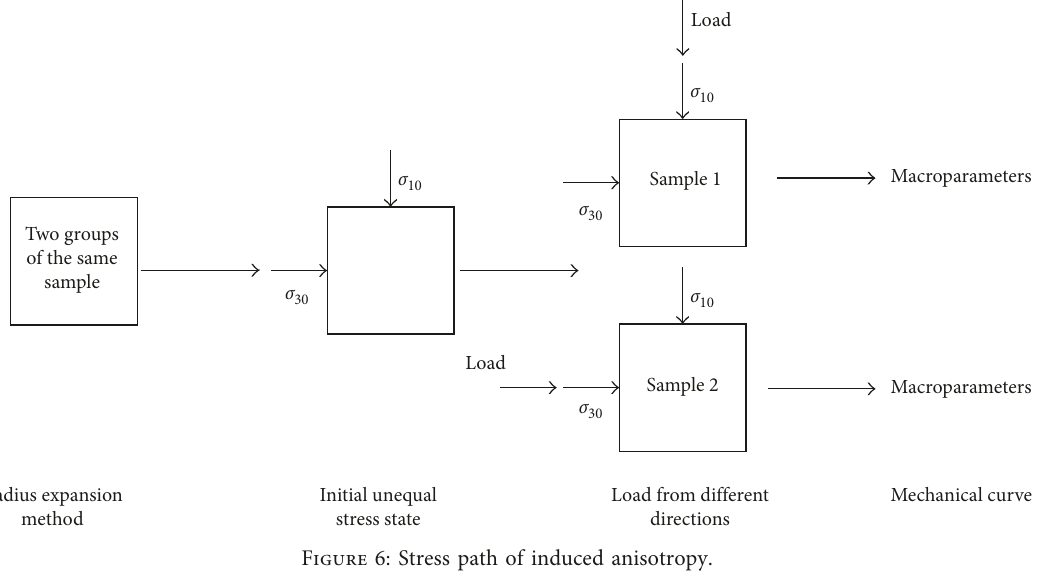
Figure 6: Stress path of induced